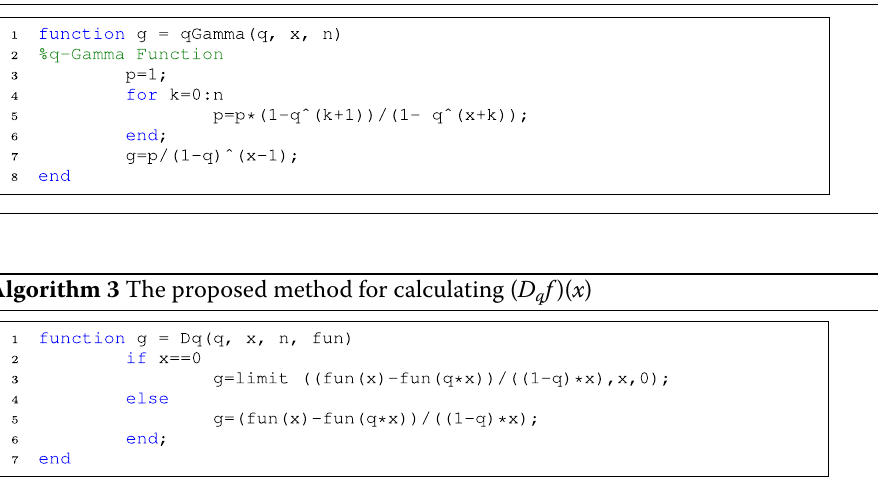
Algorithm 2 The proposed method for calculating Γ q ( x )